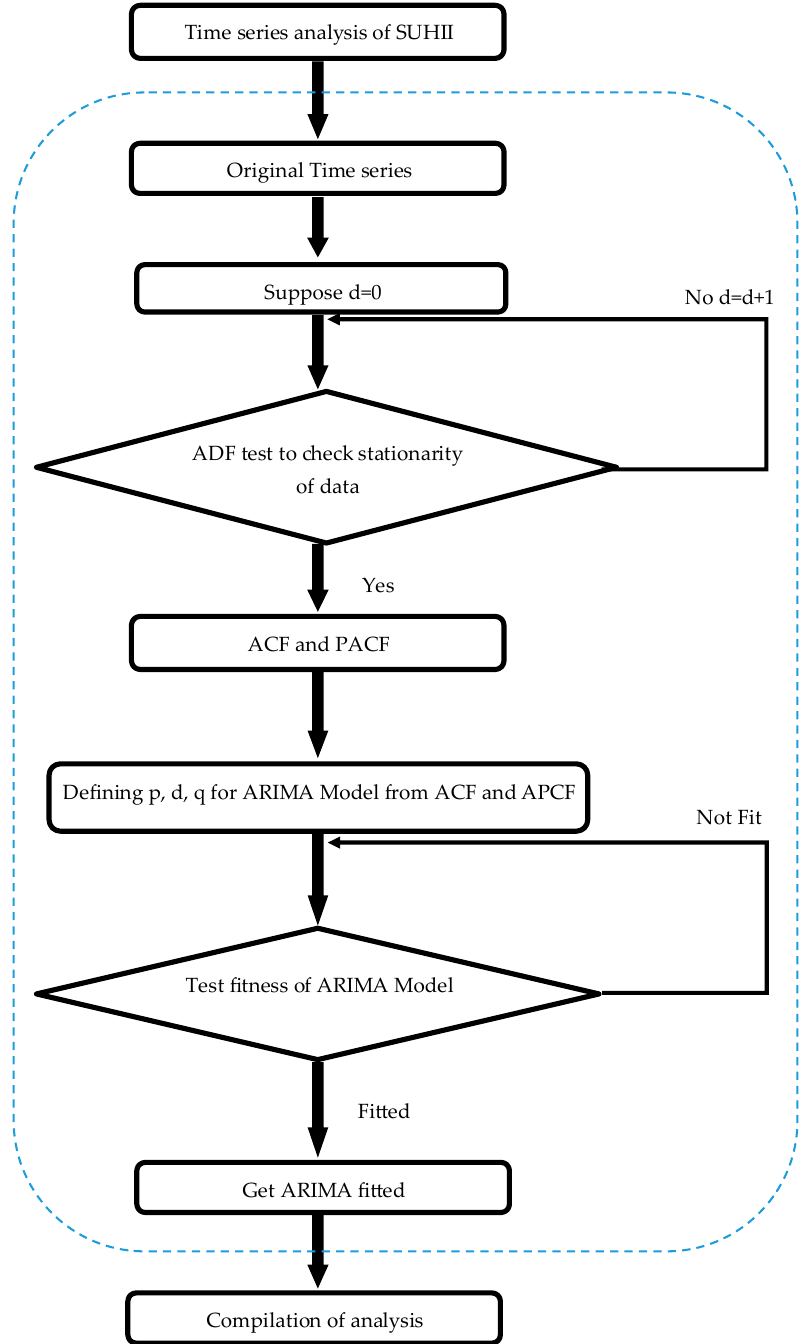
Figure 3. Fitting of the ARIMA model .